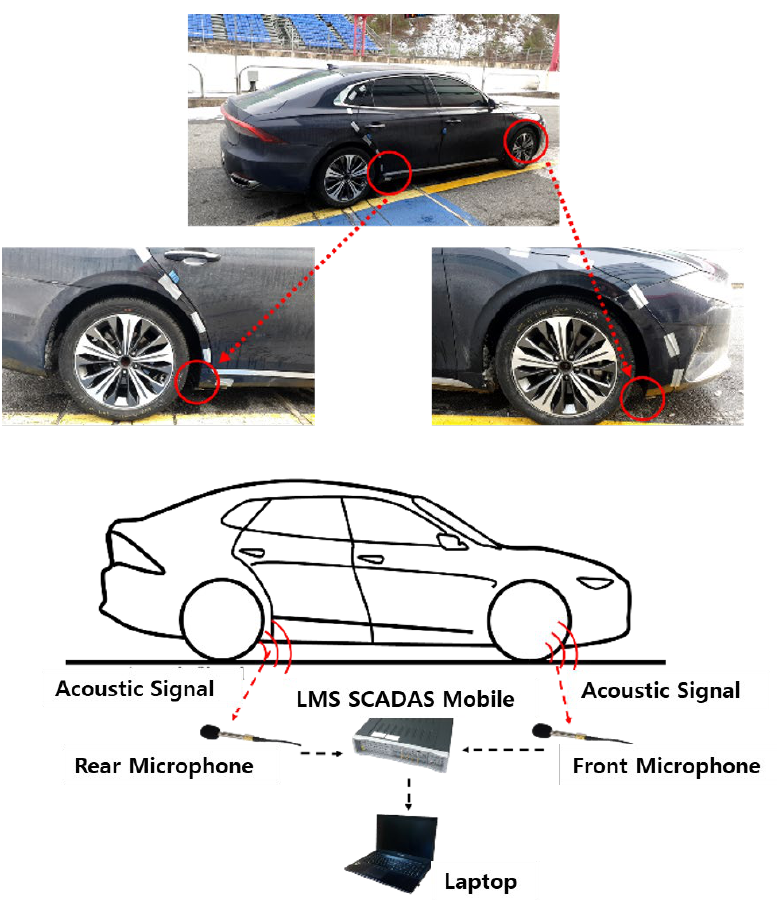
Figure 5. Setup of instruments for the measurement of a TPIN signal.